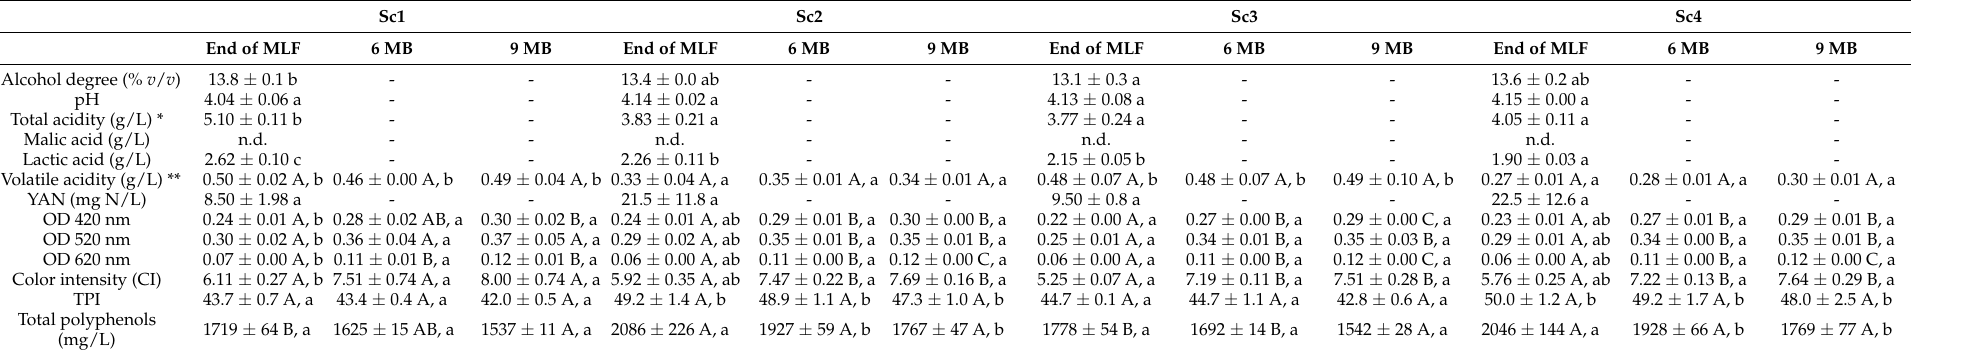
All parameters are given as average values ± SD (n = 2). n.d.: not detected. -: not analyzed. YAN: yeast assimilable nitrogen. OD: optical density. TPI: total polyphenol index. * As g/L of tartaric acid. ** As g/L of acetic acid. For each yeast, different capital letters indicate significant differences, using the Duncan test ( p ≤ 0.05), between aging moments. For each moment, different lowercase letters indicate significant differences, using the Duncan test ( p ≤ 0.05), between wines elaborated with the 4